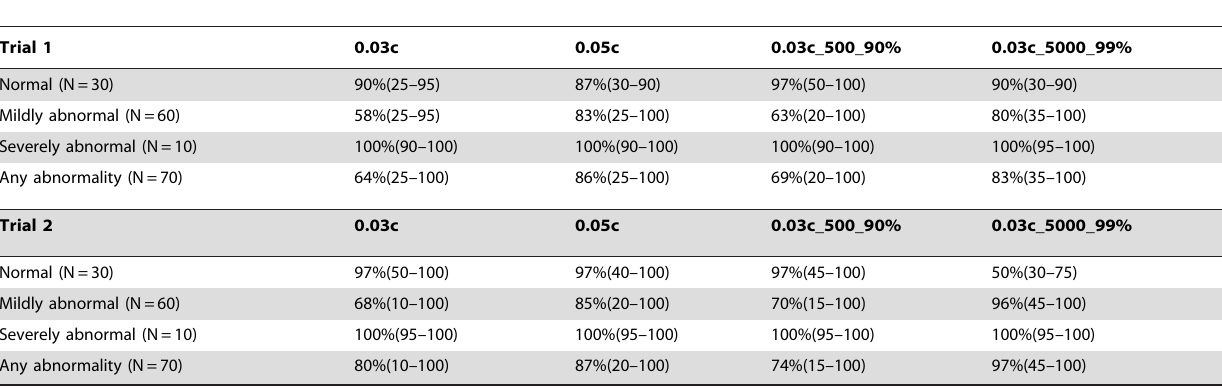
Table 3. The percentage of HITs correctly classified by the majority ( . 50%) of KW’s, with range of percentage of correct ‘‘votes’’ for each image category in brackets.